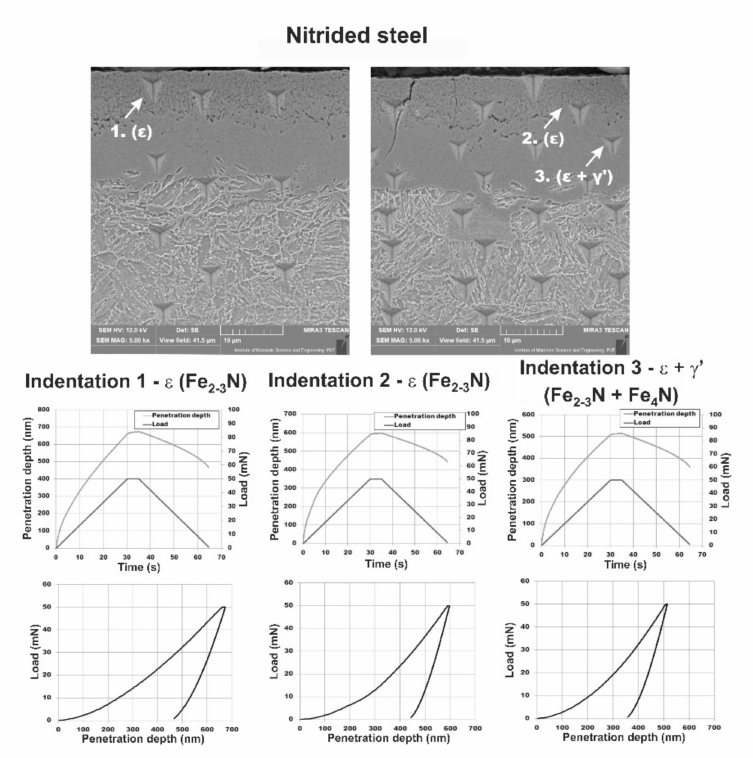
Figure 12. SEM images of indentations and the corresponding curves in gas-nitrided layer: ε (Fe 2-3 N) iron nitrides—indentations 1 and 2, ε + γ ’ (Fe 2-3 N + Fe 4 N) mixture of iron nitrides—indentation